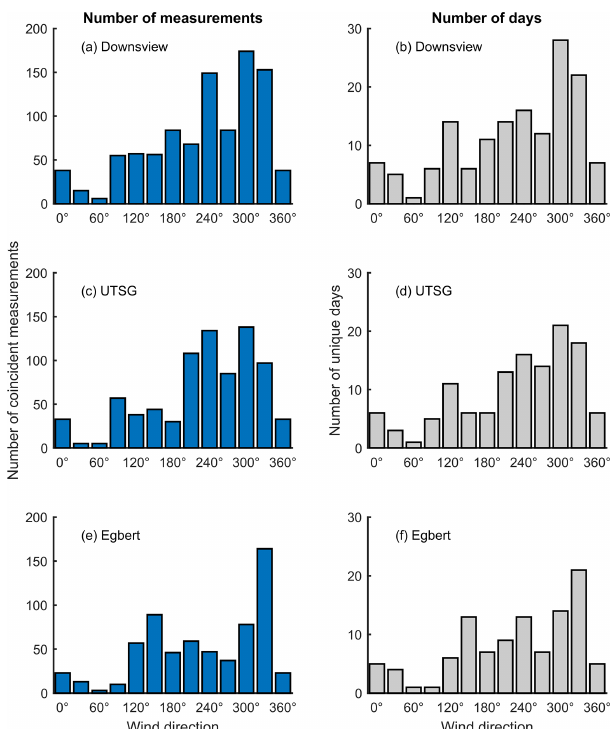
Figure A1. The number of coincidences of TROPOMI and Pandora measurements and number of unique days for each wind bin for the data shown in Figs. 6 and